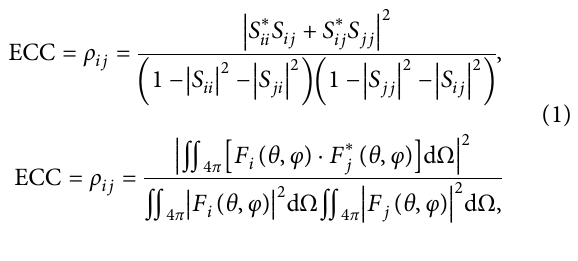
Figure 5: Geometry of the MIMO antenna. (a) Top view and (b) bottom